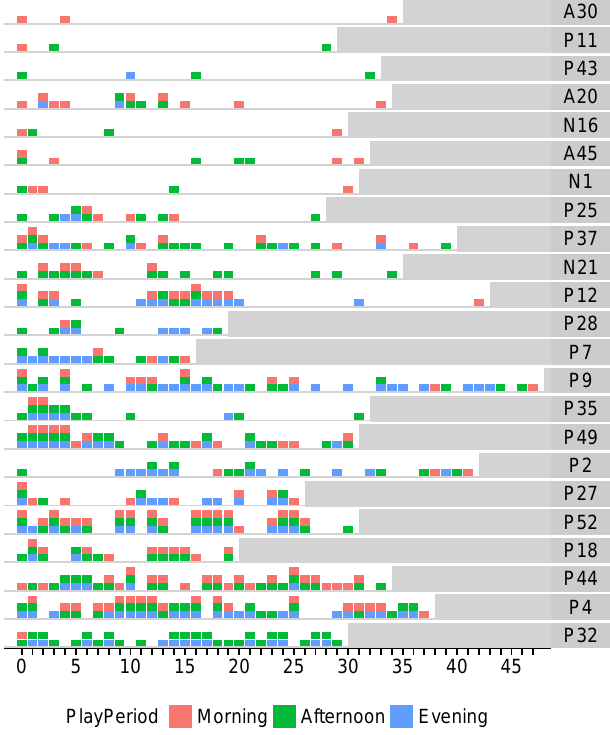
Figure 3. WAM usage by participant (rows) over time in the trial ordered by usage in minutes per day - each box indicates at least one game started during the morning (before noon), afternoon (before 6pm), or evening (after 6pm). Apparent order violations, e.g. P20, are due to incomplete sessions.